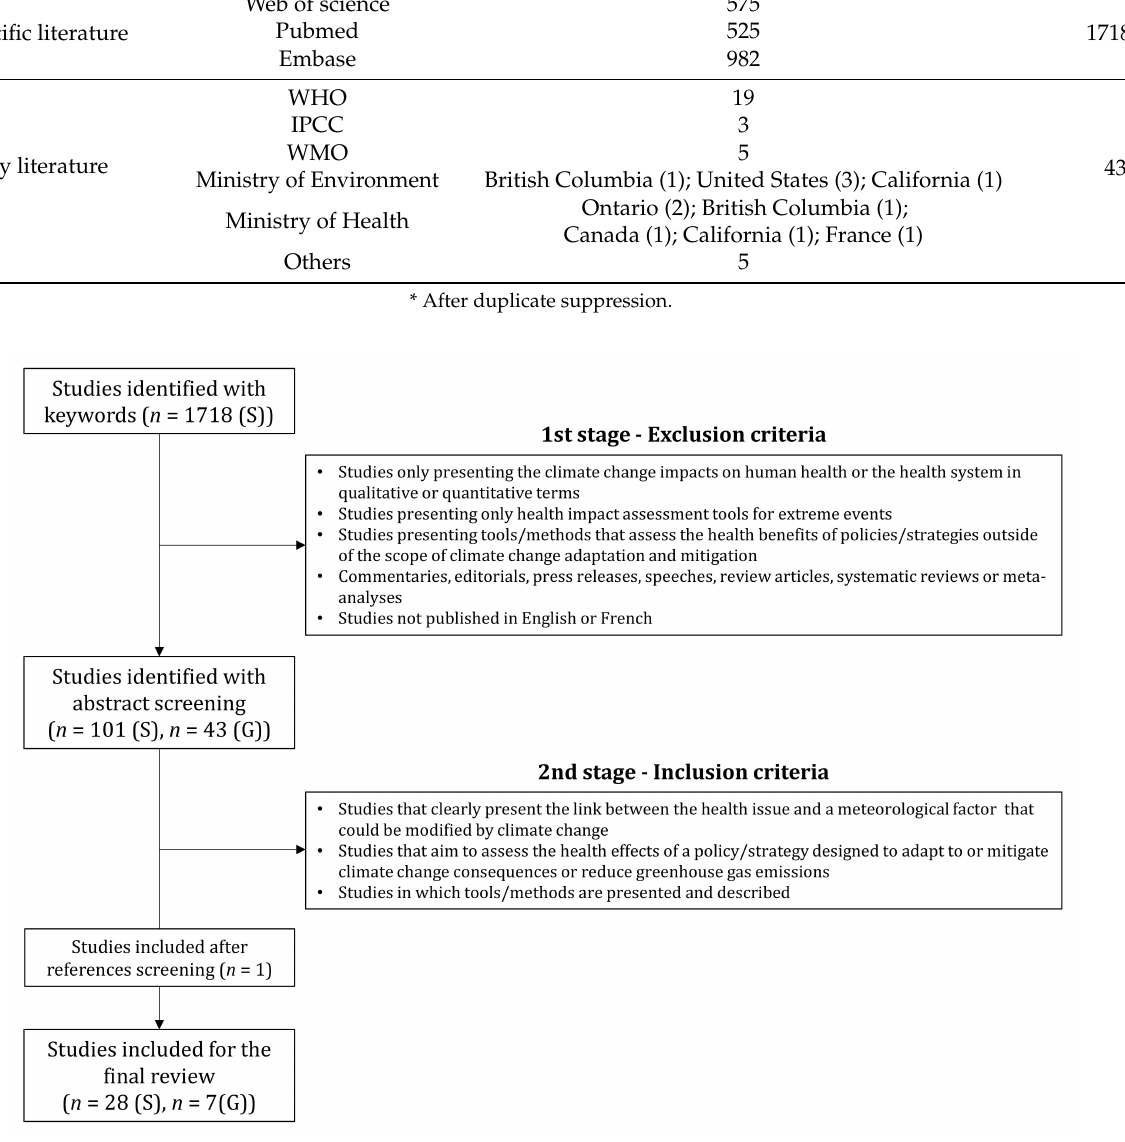
Figure 1. Data research results (S: Scientific literature; G: Grey